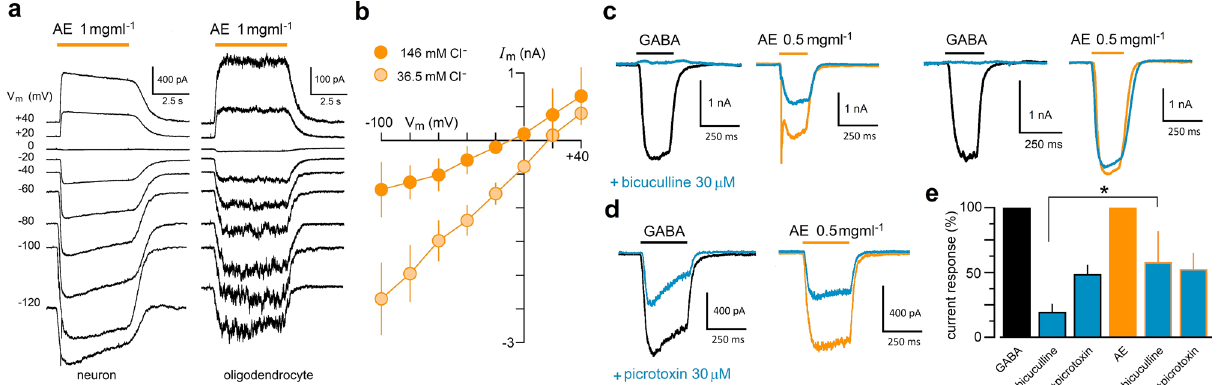
Figure 7. Ionic basis and pharmacology of inward currents generated by AE in neural cells. ( a ) Traces illustrate typical current response elicited by AE (1 mg ml −1 ) at different potentials either in neurons or in oligodendrocytes; in both cases extract generated inward currents that presented an E rev close to 0 mV. ( b ) Current–voltage relationship for the response to AE were monitored in neurons in two conditions, first in control external solution containing 146 mM Cl − (dark orange circles) and then the same cell in external solution containing 36.5 mM Cl − (light orange circles). In low Cl − external solution the E rev shifted to more positive potentials. ( c ) Bicuculline (30 μM) was tested for its effect on the inward current response elicited by AE (0.5 mg ml −1 ). Neurons were tested for their response either to 5 μM GABA (black traces) or to AE (orange traces) and then the inhibitory effect of bicuculline (blue traces) was tested in each case. For GABA response bicuculline showed a strong inhibitory effect in all cases, while the effect on AE-elicited response was less potent and more variable between different neurons (two different neurons are illustrated). ( d ) In similar experiments, picrotoxin (30 μM, blue traces), inhibited in comparable manner to both the GABA- and the AE-response. ( e ) Normalized responses (mean ± S.D.) obtained in 8 neurons for each condition are shown in the bar graph. Current response in the presence of each drug was normalized against the corresponding amplitude reached by either GABA or AE applied alone (*p < 0.05 for comparisons between the GABA vs. AE amplitude values in the presence of